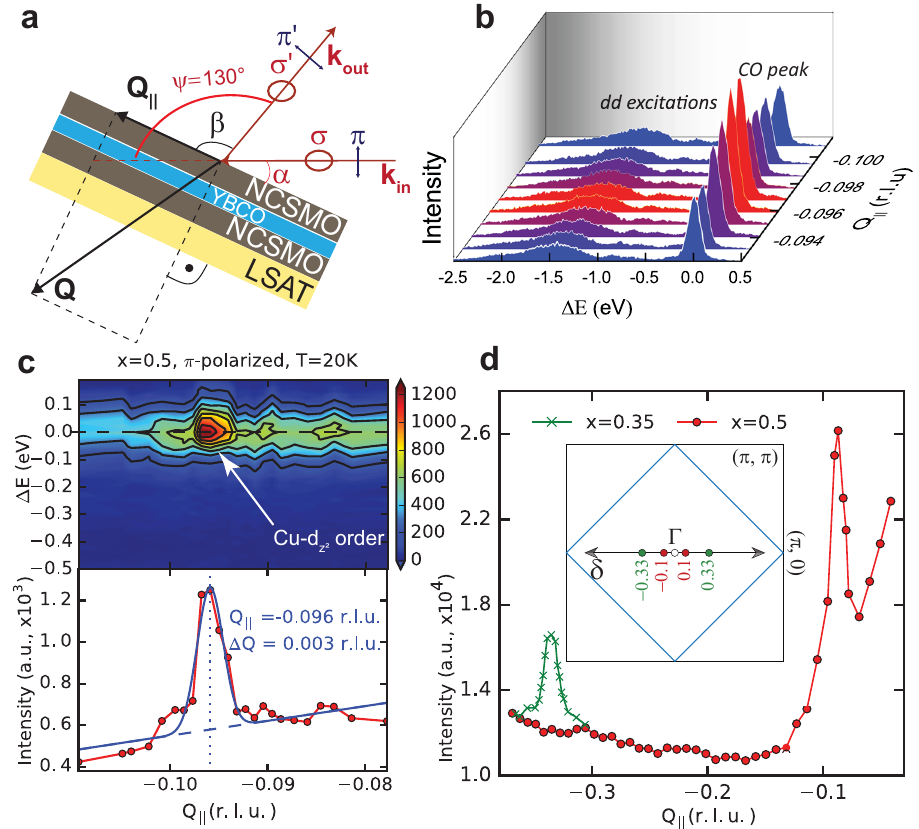
Fig. 1 Overview of the incommensurate Cu density wave orders in NYN trilayers obtained with RIXS. a Schematic of the RIXS experiment at the Cu L 3 -edge with X-rays with linear σ - and π -polarization. The scattering angle between incoming and outgoing beams is Ψ = 130°. The angle δ , which gives the projection of transferred momentum along the surface direction, is de fi ned as zero when the angles α and β are equal (specular re fl ection), i.e., δ Ψ /2 – α . Therefore, grazing incidence corresponds to δ > 0, while grazing exit corresponds to δ < 0. b Observed RIXS spectra for different Q || at the Cu L 3 -edge for the trilayer with x = 0.5 showing the elastic peak ( Δ E = 0) enhancement due to the CO and the inelastic signals ( Δ E < 0, at an incidence energy of 930.4eV). c Evolution of the elastic peak intensity ( Δ E = 0) in π -polarization as a function of Q || , showing a pronounced Bragg peak at Q || ≈ 0.096 r.l.u. due to a Cu-based order. d Wide-range Q || -scan showing that the ordinary Cu-CDW Bragg peak around Q || ≈ 0.33 r.l.u. is absent for the trilayer with x = 0.5. Shown for comparison are RIXS data of a trilayer with x = 0.35 for which this latter Bragg peak is present and enhanced with respect to bulk YBCO (adapted from ref. 22 ). The inset shows a schematic of the Brillouin zone and the positions of the two charge order peaks, which appear symmetrically about the Γ -point along the ( π , 0)